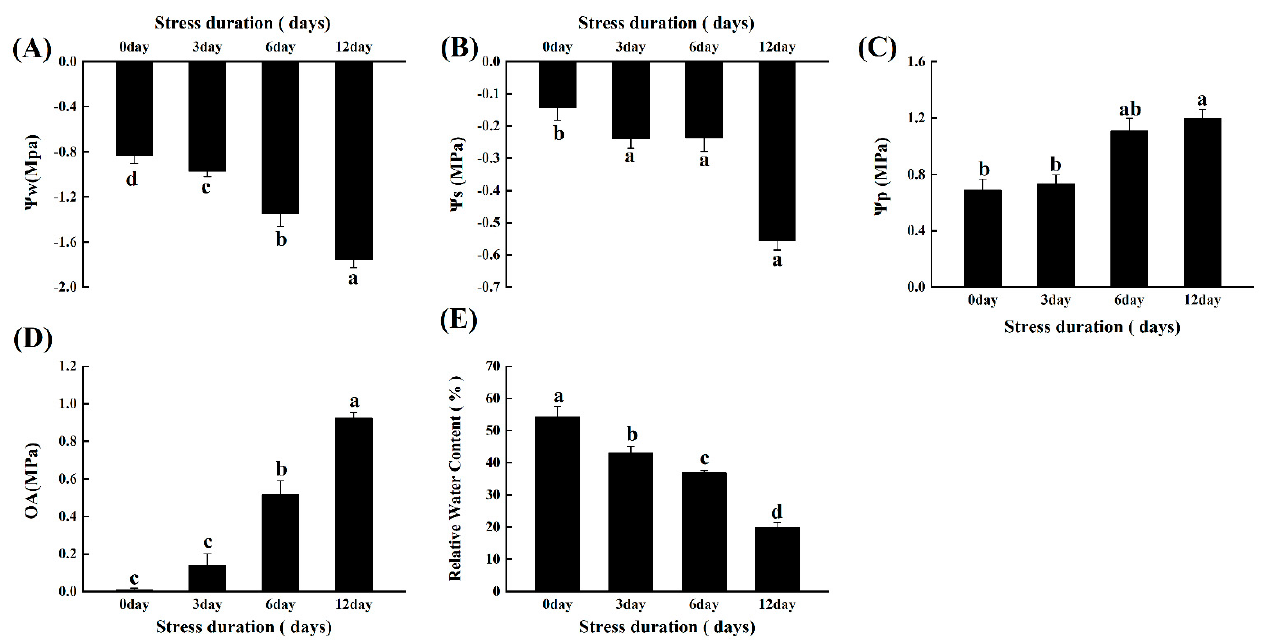
Figure 2. Effects of salt stress on ( A ) water potential ( Ψ w); ( B ) osmotic potential ( Ψ s); ( C ) turgor potential ( Ψ p); ( D ) osmotic adjustments (OA) and ( E ) relative water content (RWC) in leaves of tomato seedlings grown for 12 days under control and salt stress. Values are mean ± SD (Standard Deviation) of three replications. Different letters indicate significant differences at p ≤ 0.05 (Tukey’s HSD test).